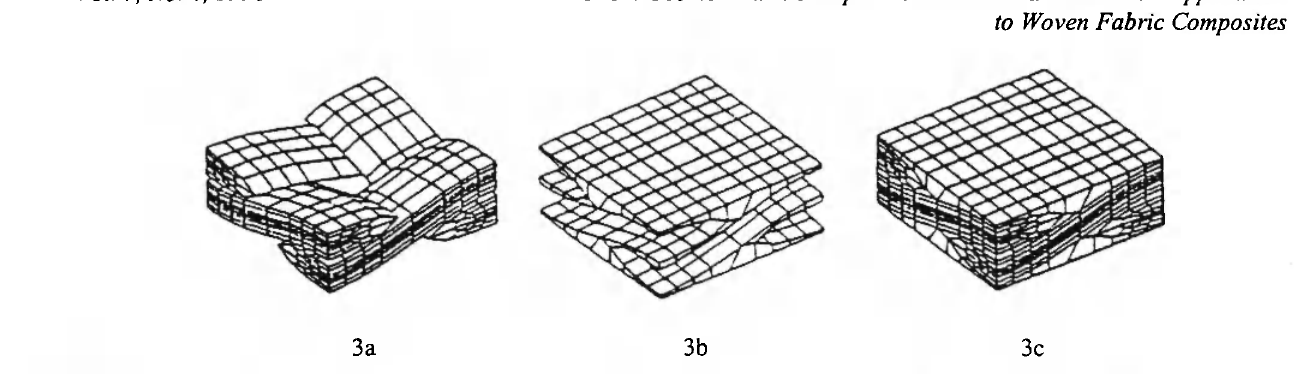
Fig. 3: Steps of the automatic meshing. 3a) yarn meshing, 3b) matrix meshing (by boolean calculations), 3c) whole meshed unit-cell.